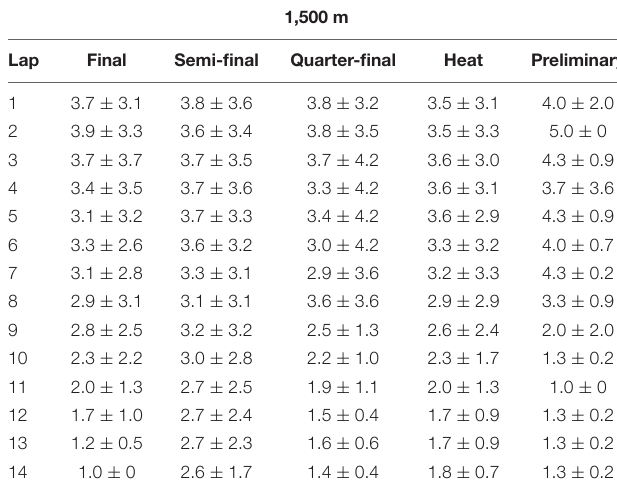
TABLE 4 | Mean value and standard deviation of lap rankings for 1,500 m